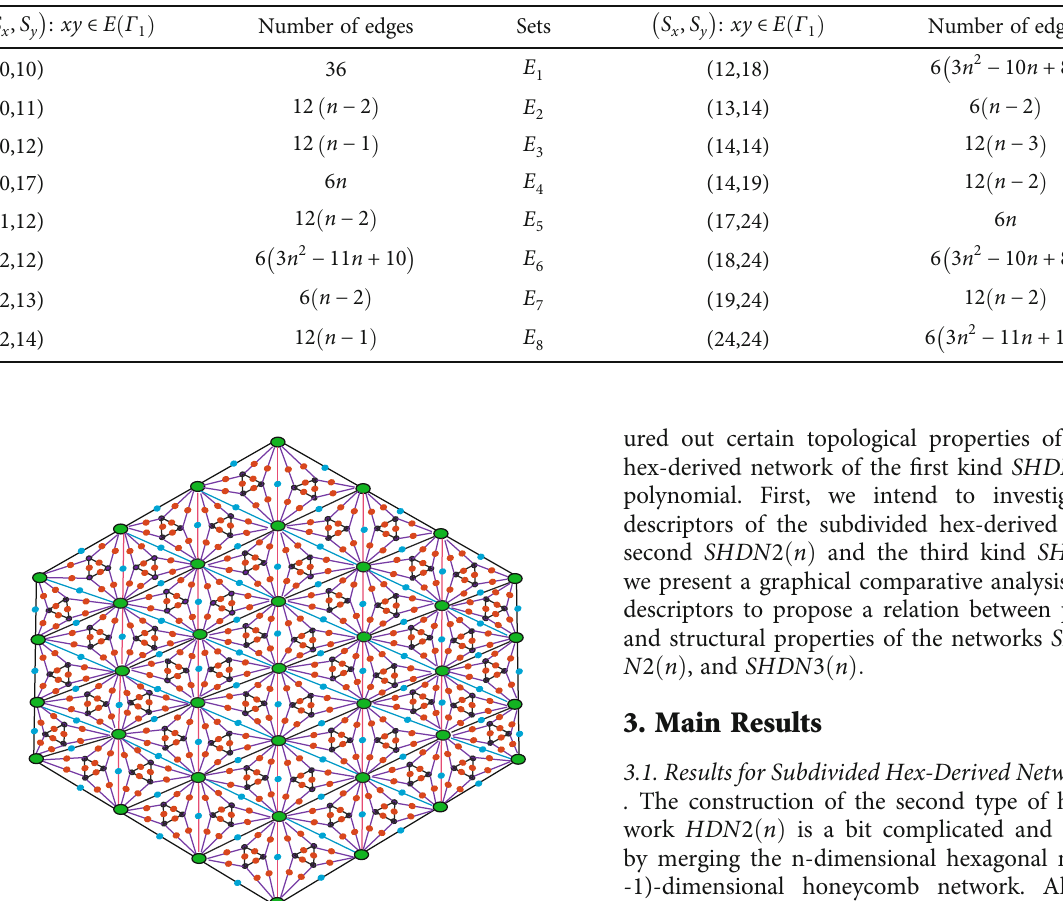
Table 2: Edge partitioning of Γ